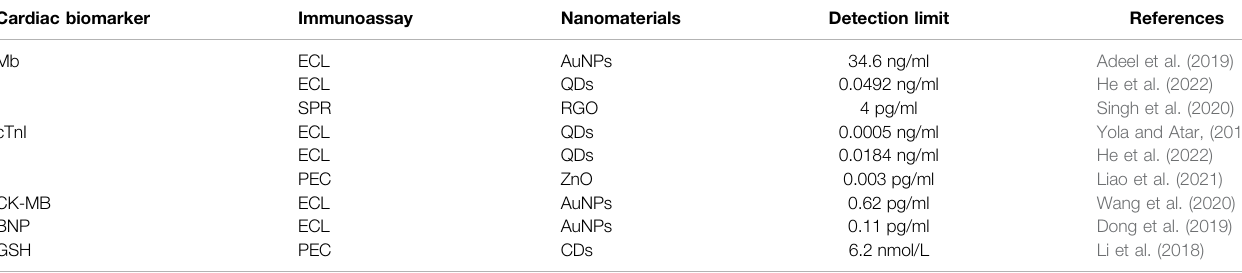
TABLE 2 | Summary of nanomaterials-based immunoassay for MI diagnosis. Cardiac biomarker